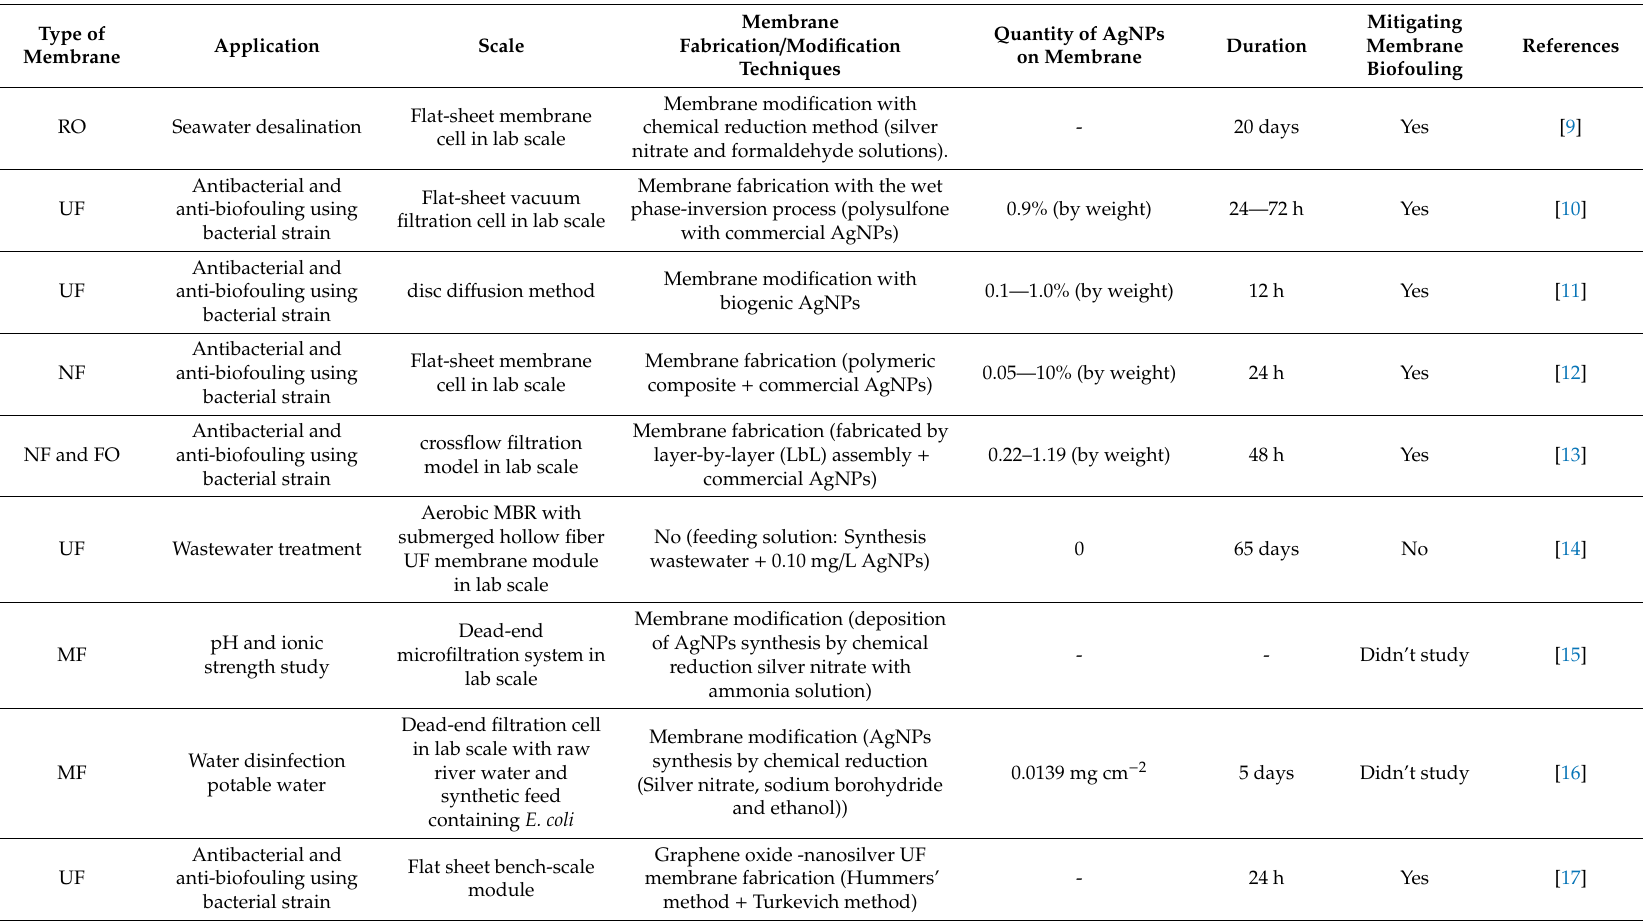
Table 1. Summary on membrane fabrication / modification bases on silver nanoparticles (AgNPs) coating